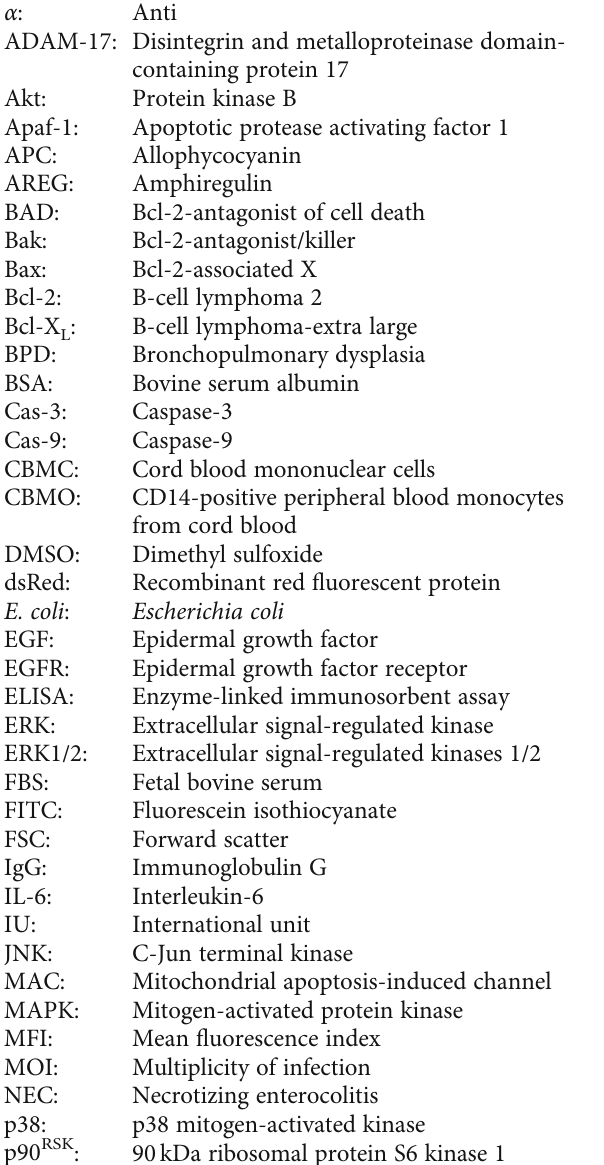
Supplementary Figure 1: examples of immunoblots used for quanti fi cation of MAPK activation. Blots represent at least two of three independent samples. MAP kinases are given in the fi gure. Note that the ERK MAP kinase blot shows an additional sample. (Supplementary